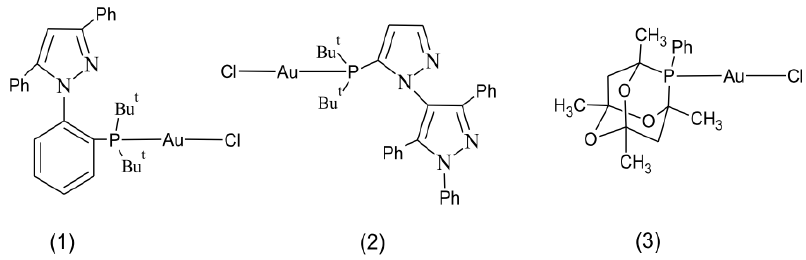
Figure 1. The schematic representation of compounds